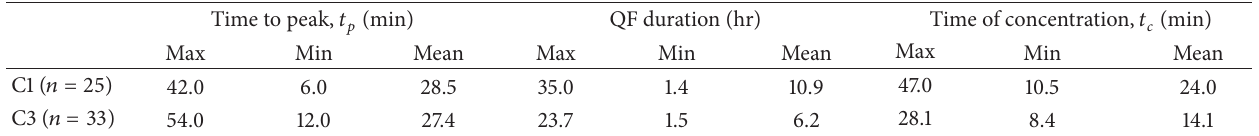
Figure 3: Relationships between stormflow (QF) and rainfall events during wet and dry conditions in control catchment C1 (a) and plantation catchment C3 (b) for observation from January 2006 to June 2007. Table 3: Single peak hydrograph characteristics in C1 and C3 for 2007 water year. The parameters include time to peak ( 𝑡 𝑝 ), quick flow (QF) duration, and time of concentration ( 𝑡 𝑐 ) with 𝑛 being the number of